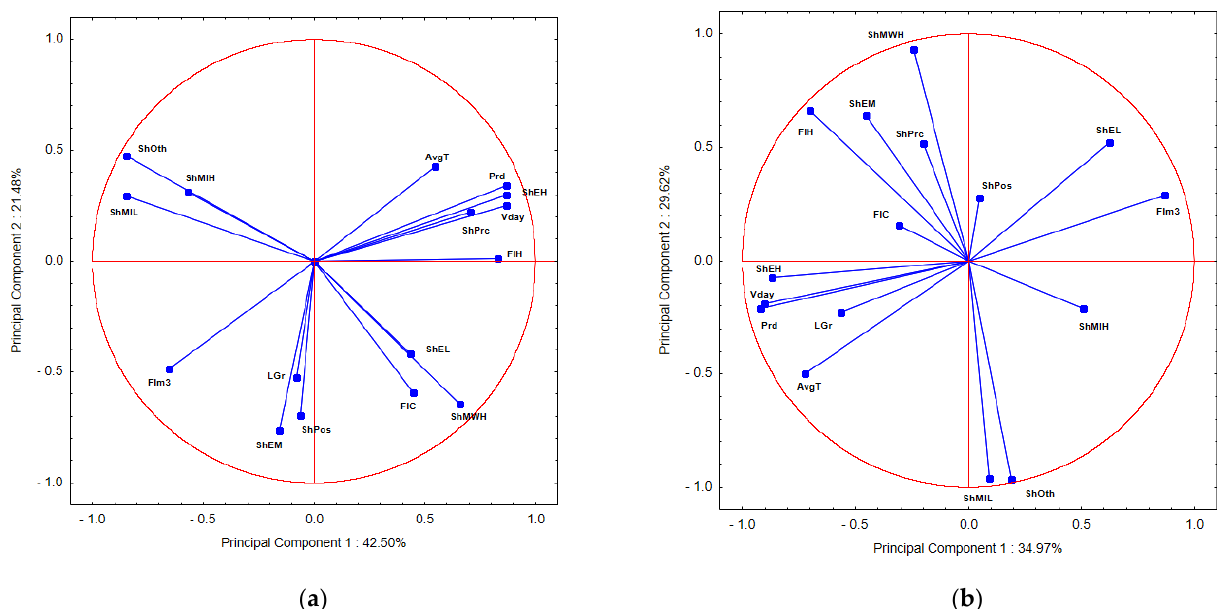
Figure 7. Loading plots of machine A ( a ) and machine B ( b ) for the first two principal components. Results of regression showed that the main factor affecting fuel consumption per cubic meter was average tree size, while for productivity apart from tree size, a share of processing time was significant. Fuel consumption per hour was affected not only by these variables, but also by the distance driven in a low gear, share of time spent idling on low RPMs and share of time the engine was running at a high load. Variables selected by dendrograms as most divisive were volume cut per day, daily fuel consumption and share of time working on high RPMs. K-means divided variables into two clusters that were more prominent each day. Days with the same dominating clusters formed series of consecutive days, which might indicate, for example, a shift in working conditions. PCA explained almost 90% of variance in the first four principal components for both machines. However, an opposite sign in common